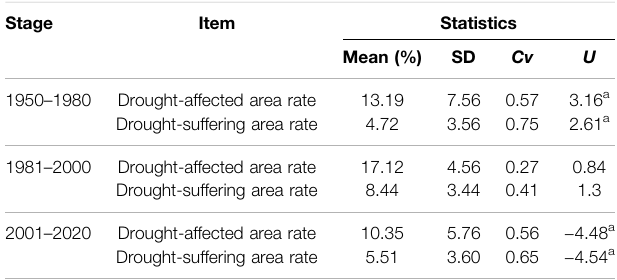
TABLE 2 | Statistics of drought-affected area rate and drought-suffering area rate based on Mann – Kendall test in 1950 – 1980, 1981 – 2000, and 2001 – 2020 Stage Item